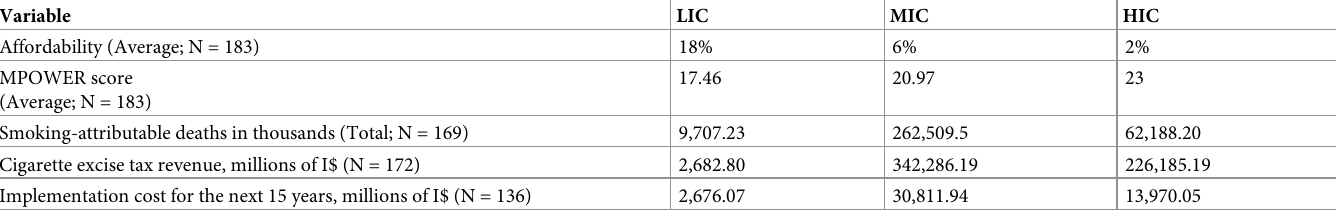
Table 1. Indicators related to tobacco control environment, policy implementation, costs, and financing,